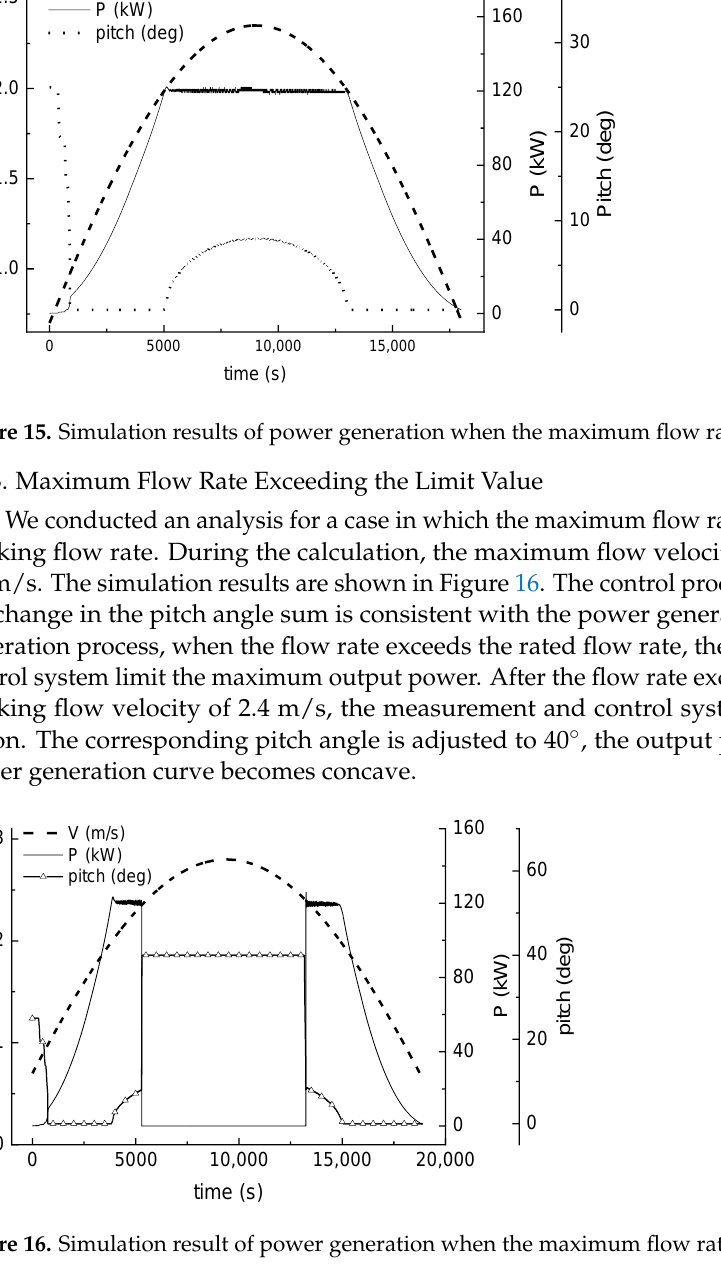
Figure 16. Simulation result of power generation when the maximum flow rate is 2.6 m/s.